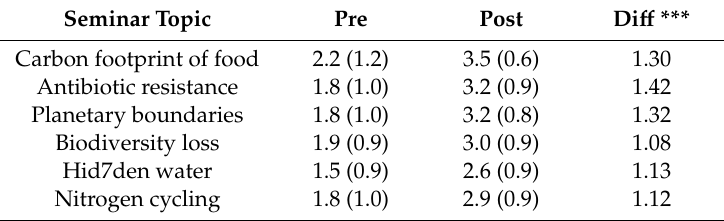
Table 7. Mean (SD) self-assessment of mastery of seminar topics, intervention students ( n =